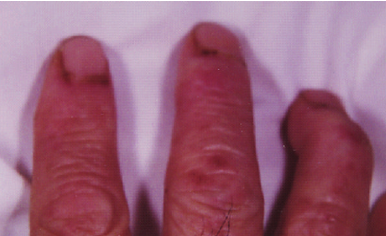
Figure 1: Gottron’s sing on the dorsal surface of the proximal interphalangeal joint. Erythematous areas at the bases of the fingernails are seen.